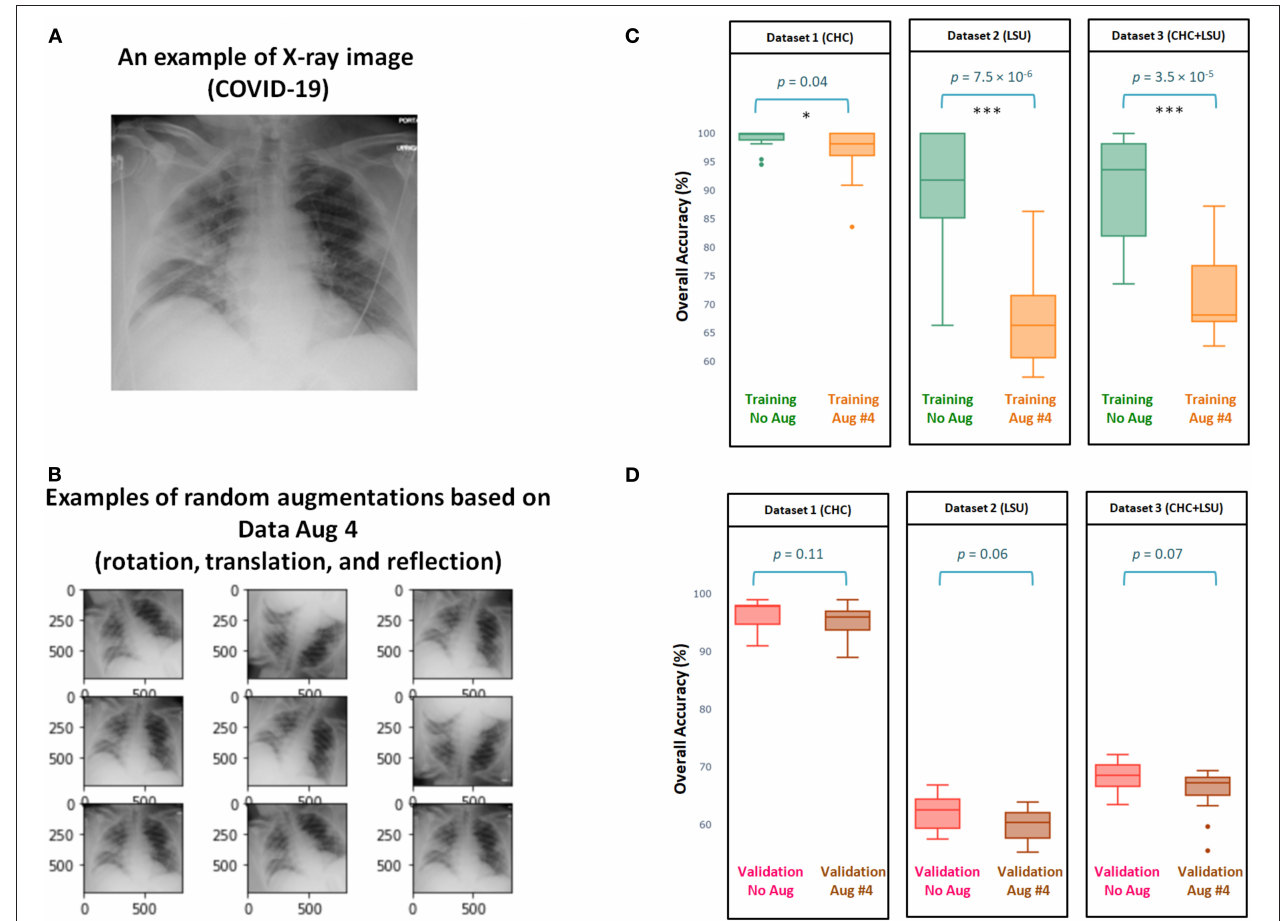
FIGURE 3 | Efficacy of Data Augmentation 4 (6) on X-ray images with and without COVID-19. (A) An example of applying Data Augmentation 4, which includes rotation by 10 degree, translation, and horizontally reflection to a COVID-19 X-ray image. (B) Comparing the overall accuracy of 17 deep neural networks to examine the efficacy of Data Augmentation 2 ( 21) when applied to three datasets. (C) Boxplots to show the overall statistical different between training with and without augmentation over three datasets. (D) Boxplots to show the overall statistical different between validation with and without augmentation. Note that results shown in (C,D) are obtained from cross validation with K =